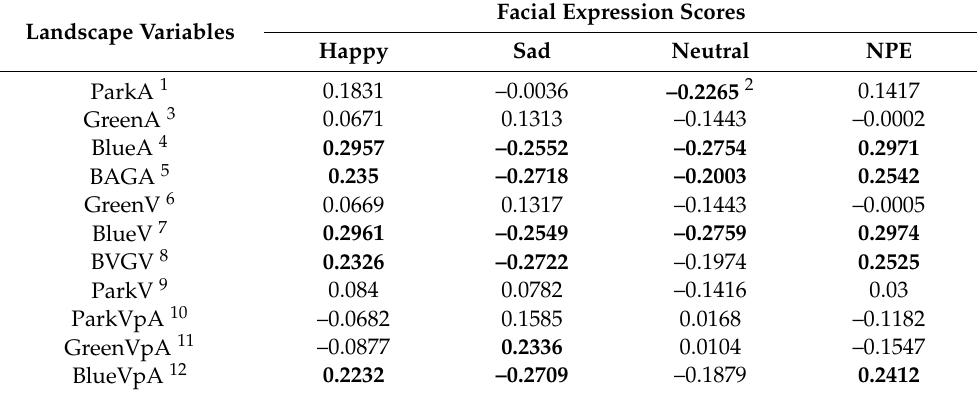
Table 2. p values from Spearman correlations between facial expression scores (happy, sad, and neutral emotions plus NPE of happy minus sad scores) and landscape variables (area and ecosystem service